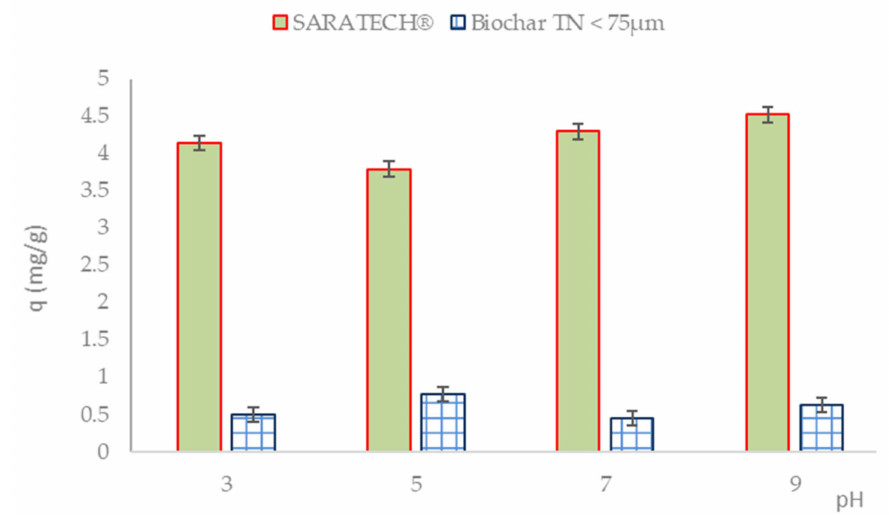
Figure 7. Effect of pH on adsorption